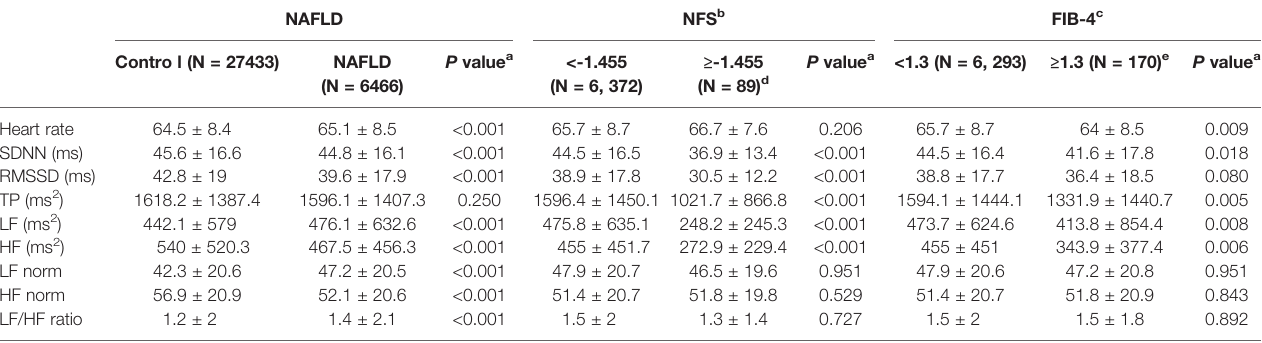
TABLE 2 | Comparison of heart rate variability indices in participants according to development of non-alcoholic fatty liver disease and possibility of advanced liver fi